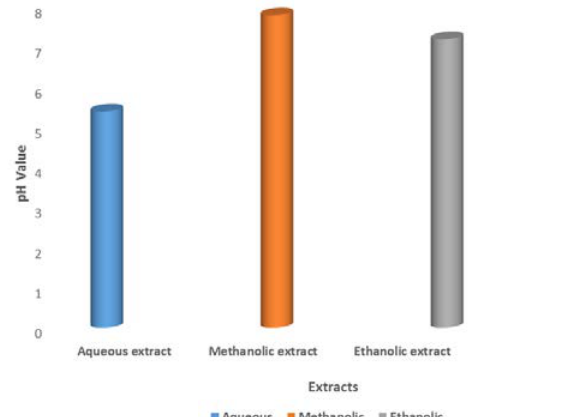
Fig. 1. The pH values of tested extracts of Senna alata